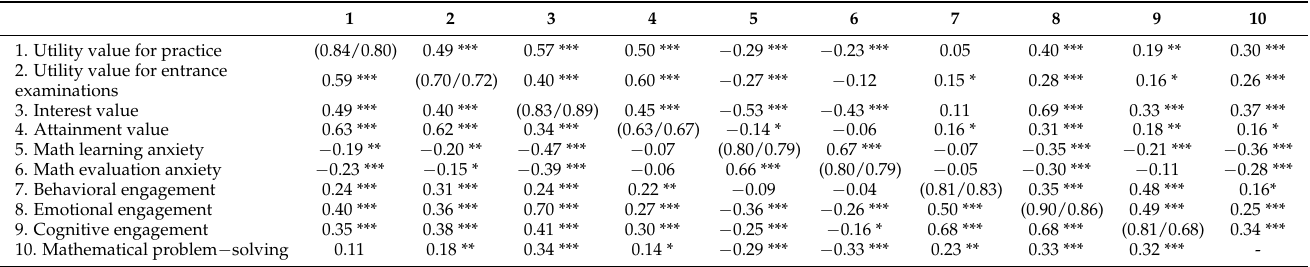
Table 3. Pearson correlation matrix for task value, math anxiety, engagement and mathematical problem